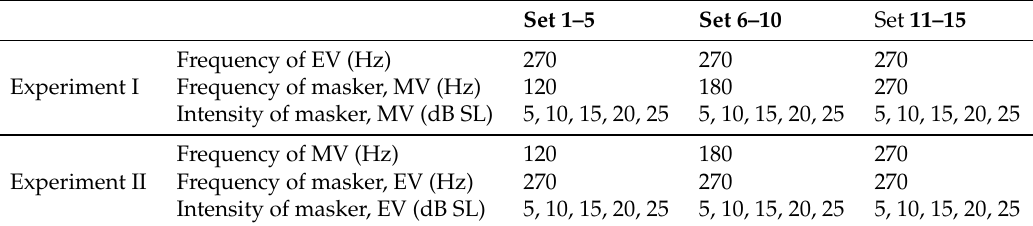
Table 1. Stimulus sets presented in Experiment I and